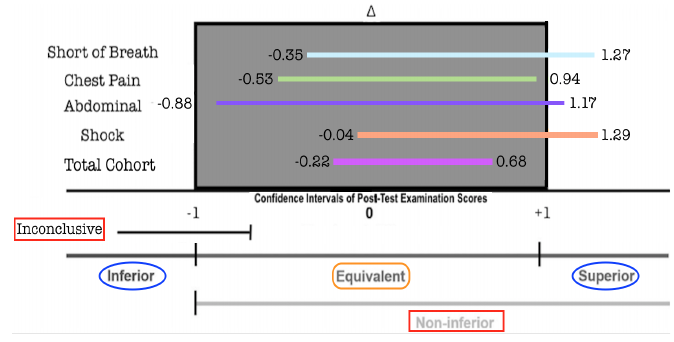
Figure 3. Analysis of post-test examination scores. X- axis depicts confidence intervals (CI) of post-test examination scores with an equivalence margin (Δ) ranging from -1 to 1. Y- axis depicts individual course subject subgroup analysis for, shortness of breath (SB), chest pain (CP), abdominal pain (AP), cardiovascular shock (CS) and mean outcome of the total cohort (TC). Boxed term in orange indicates margins of Statistical Equivalence (representing the study’s primary outcome measure). Boxed terms in red represent graph legend of possible statistical data outcomes including Non-inferiority and Inconclusive. Boxed terms in blue represent graph legend of possible statistical data outcomes including superiority and